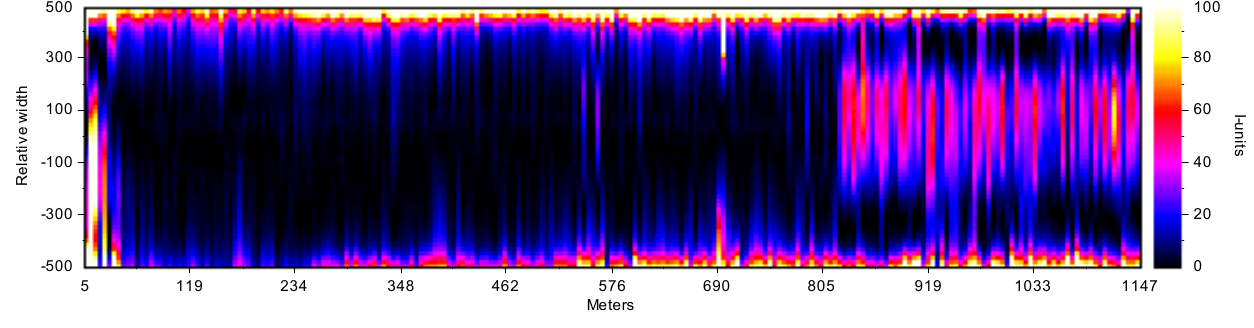
Figure 5. Flatness map built up with the flatness profiles computed for a steel strip. The first section of the product shows bad leveling; the second, wavy edges; and the third, wavy edges combined with center buckle. This flatness map has been computed by the flatness sensor described in